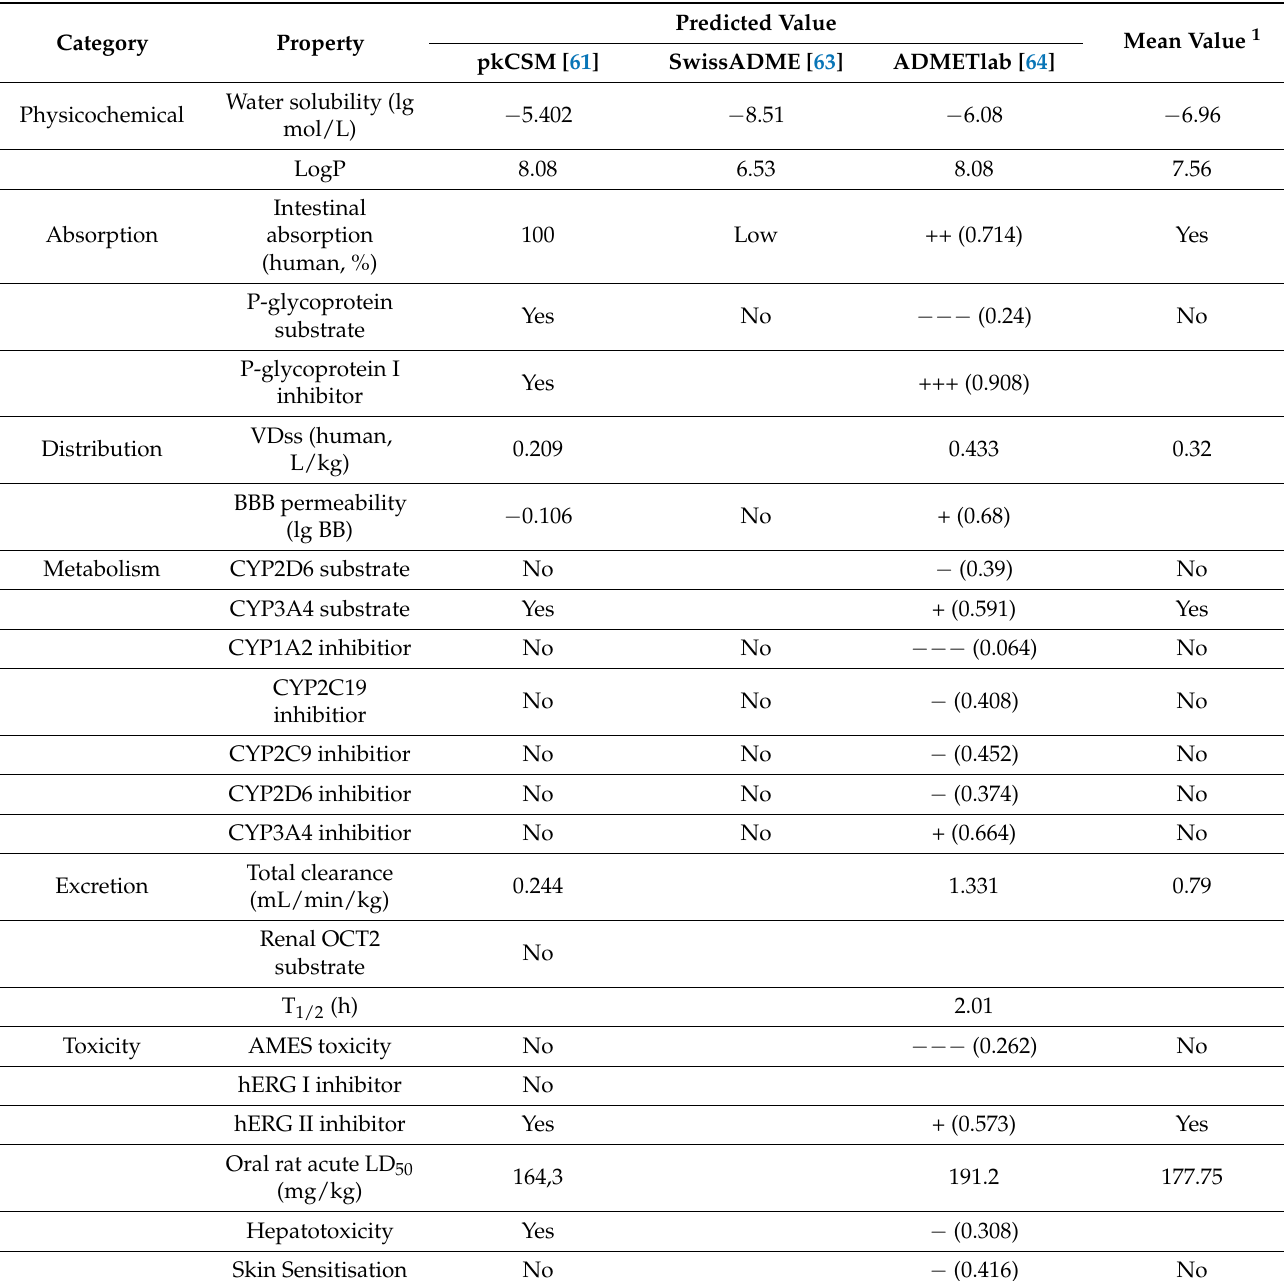
Table 6. Predicted ADMET characteristics of compound 29